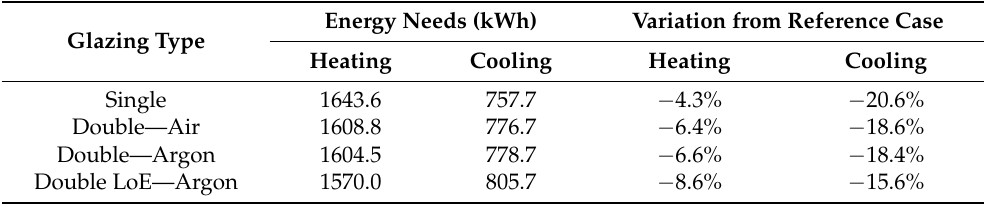
Table 6. Building’s annual energy needs and percentage change relative to the reference case varying the glazing type constituting the envelope of the sun